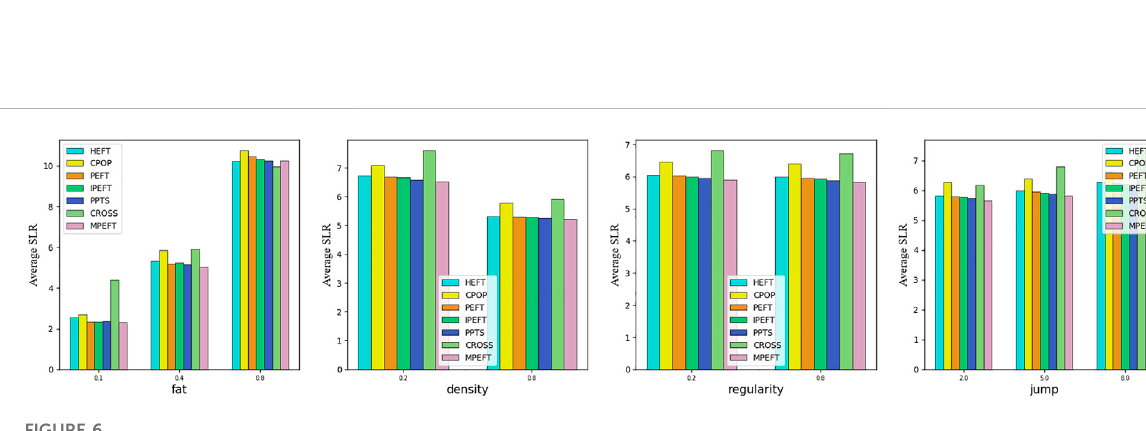
FIGURE 6 Average SLR as function of fat, density, regularity and jump for random